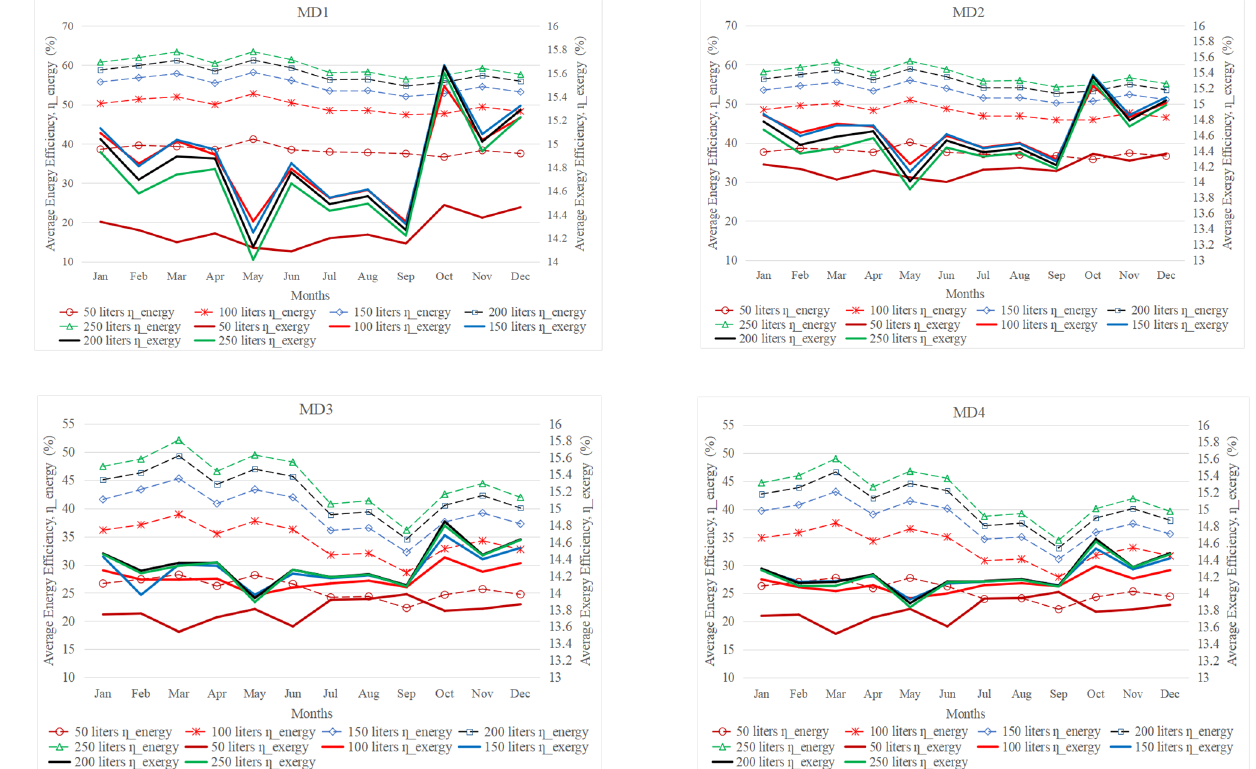
Figure 12. The average energy and exergy efficiency of AWHS when changing tank volume.